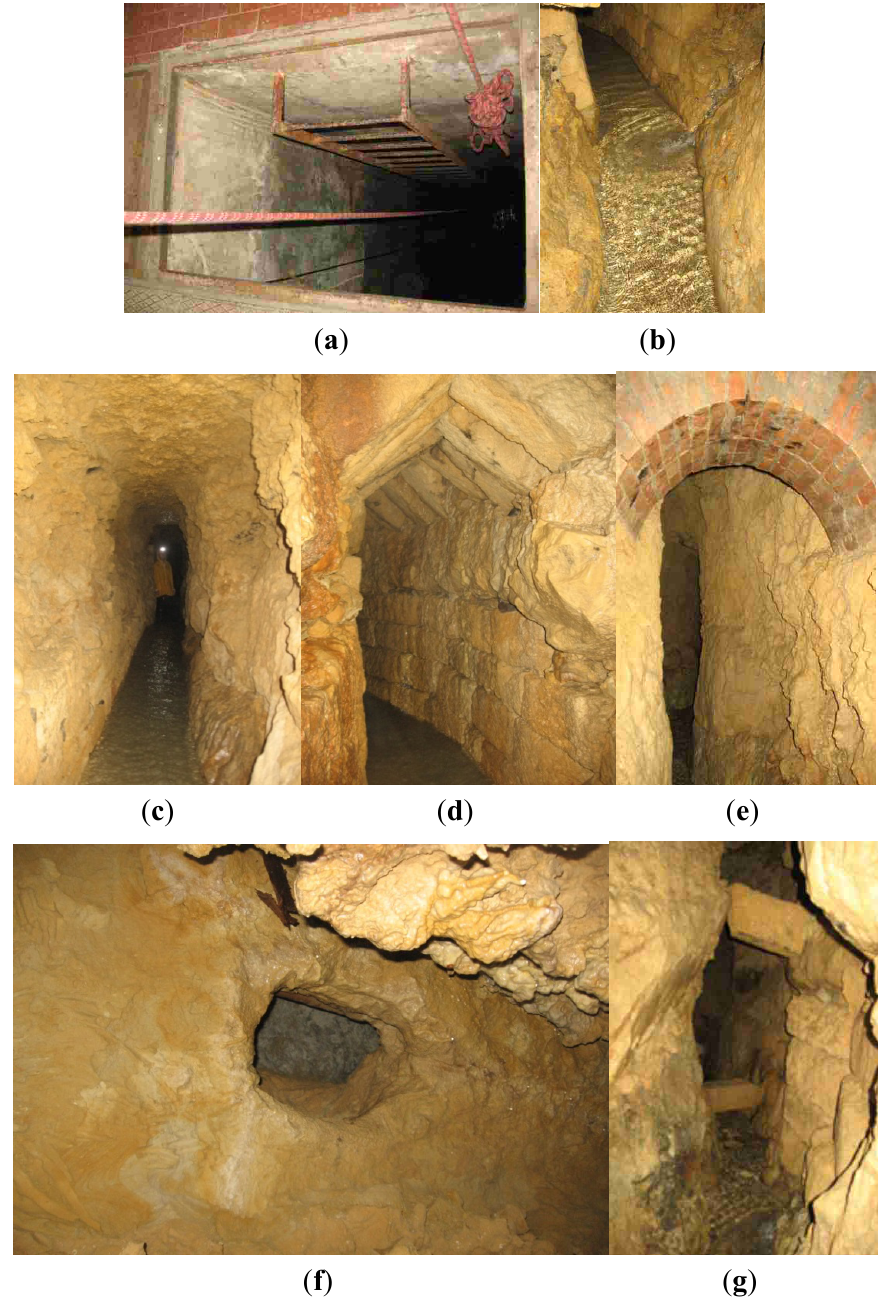
Figure 6. Gesuitico Alto qan ā t : ( a ) entry point; ( b ) spring feding the qan ā t ; ( c ) limestone walls; ( d ) gabled roof tunnel with walls covered by limestone bricks; ( e ) clay brick arch; ( f ) mouth of vertical shaft; ( g ) step shaped